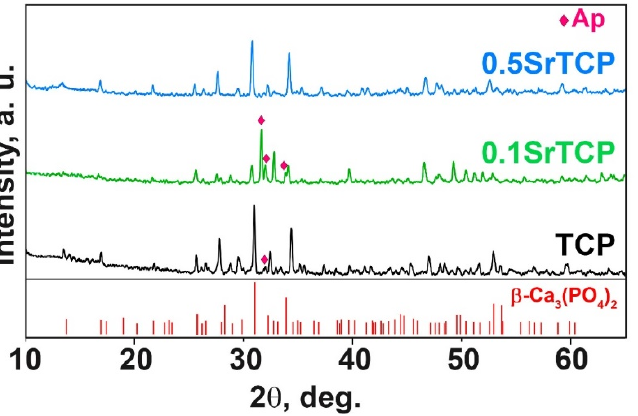
Figure 3. XRD patterns of TCP, 0.1SrTCP, and 0.5SrTCP samples calcined at 1100 °C along with PDF#2 card No 70 ‐ 2065 ( β‐ Ca 3 (PO 4 ) 2 ). PDF#2 card No 70-2065 ( β -Ca 3 (PO 4 ) 2 ).